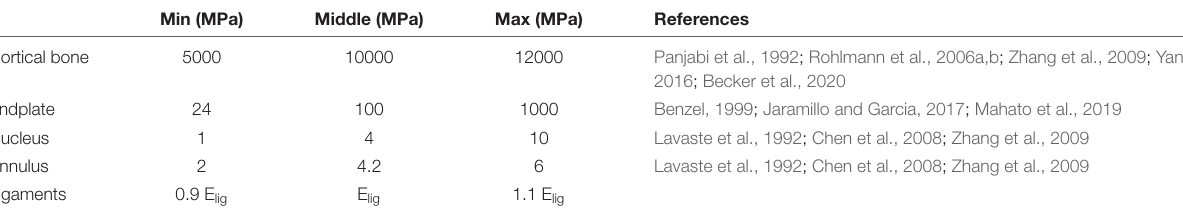
TABLE 2 | Material properties uncertainties employed for the parametric